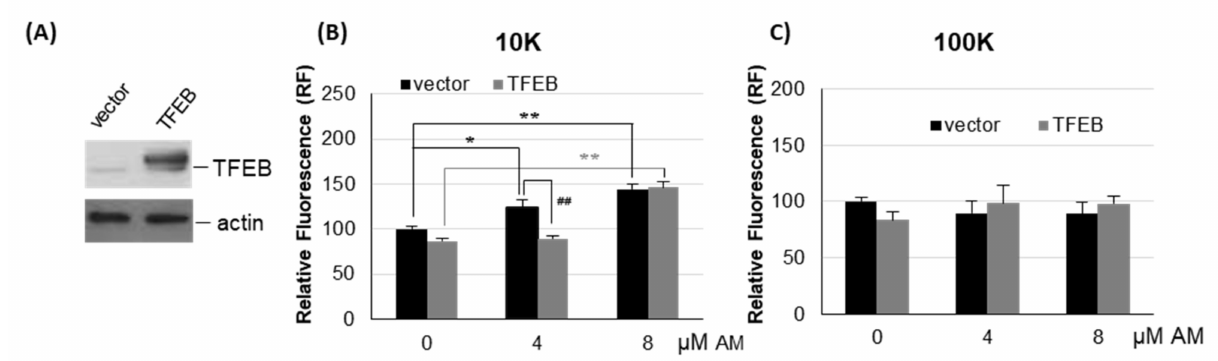
Figure 9. Effect of AM on EVs release in HEK-mCherry-CD63 transfected with TFEB . ( A ) Immunoblotting of cells transfected with TFEB. Extracts from cells transfected with TFEB or empty vector as control (vector) were incubated with an anti-TFEB antibody. As internal control, an anti- β -actin antibody was used. ( B , C ) HEK-mCherry-CD63 cells transfected with TFEB or empty vector as control (vector) were incubated for 24 h with 4 and 8 µ M AM. EVs were obtained by culture medium centrifugation at 10,000 × g (10K) and 100,000 × g (100K). Pellets were resuspended in 100 µ L PBS and assayed for fluorescence at 580 nm/620 nm (ex/em). Results represent the mean ± SE of three independent experiments performed in duplicate and are the reported percentage of empty vector transfected/vehicle-treated cells as control (set 100). * p < 0.05, ** p < 0.01, vector transfected drug-treated cells vs. vehicle, as control; ** p < 0.01, TFEB transfected drug-treated cells vs. vehicle as control; ## p < 0.01, TFEB vs. empty vector transfected cells as